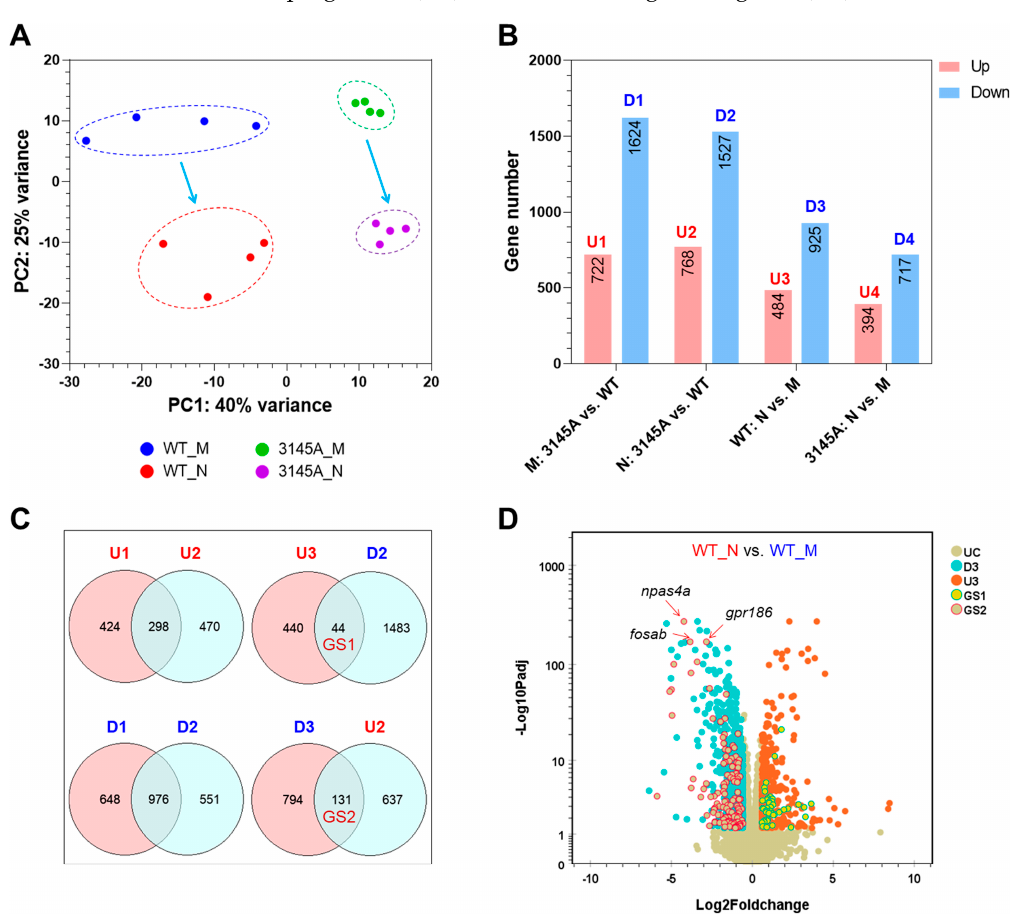
Figure 7. Effects of prkcaa mutation on gene expression. ( A ) Results of PCA. The proportion of variance explained by the first two PCs is displayed. ( B ) Numbers of the differentially expressed genes (DEGs). U1 to U4, the upregulated (up) gene sets; D1 to D4, the downregulated (down) gene sets. M and N represent the sampling time; M, morning (9:00 a.m.); N, night (9:00 p.m.). ( C ) Venn diagrams indicating the intersection between the gene sets. GS1 and GS2 represent the circadian genes regulated by the prkcaa mutation. ( D ) A volcano plot demonstrating the DEGs of the indicated gene sets. UC, unchanged; D3 and U3, the same as in (C). The representative circadian genes downregulated at night and upregulated by the prkcaa mutation are indicated.